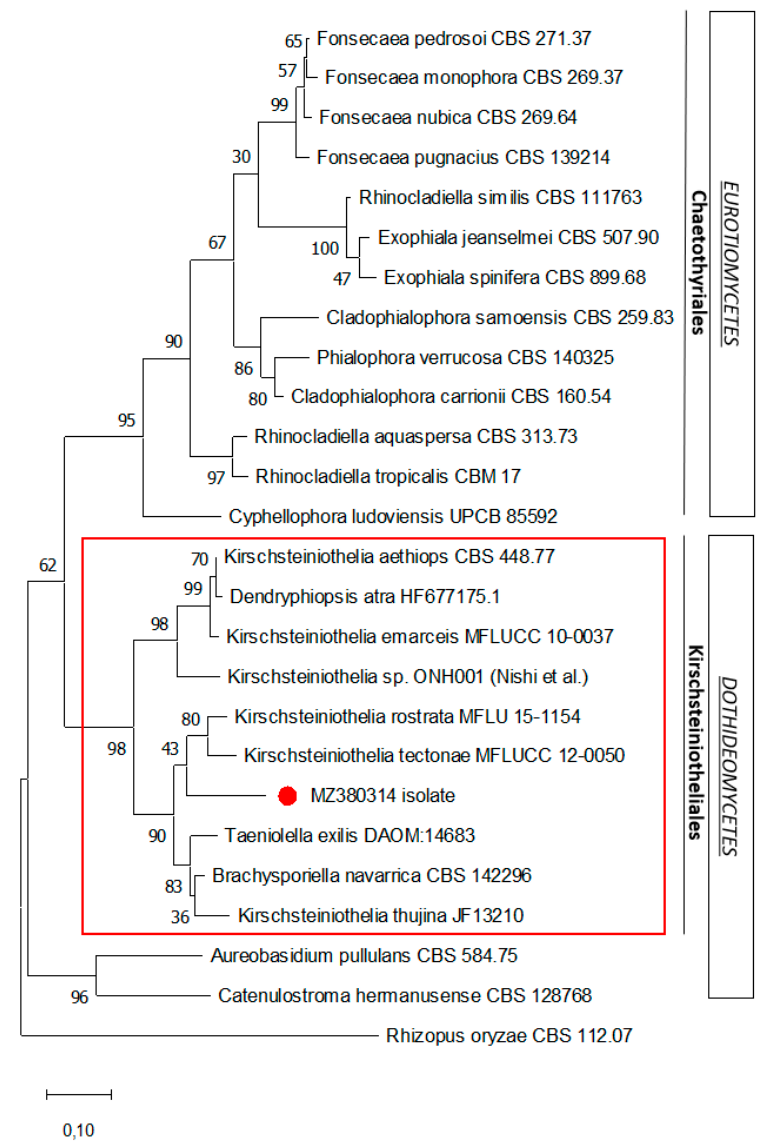
Figure 4. Maximum likelihood phylogenetic analysis of the ITS1-5.8S-ITS2 rDNA sequence of the isolate. The phylogenetic tree was constructed using the MEGA X program. The sequence related to this case is indicated by the red dot. Numerical values on the branches are the bootstrap values given as the percentage of bootstrap replications from a 2000 replicate analysis. The scale bar represents the number of substitutions per site. Rhizopus oryzae is used as an outgroup.